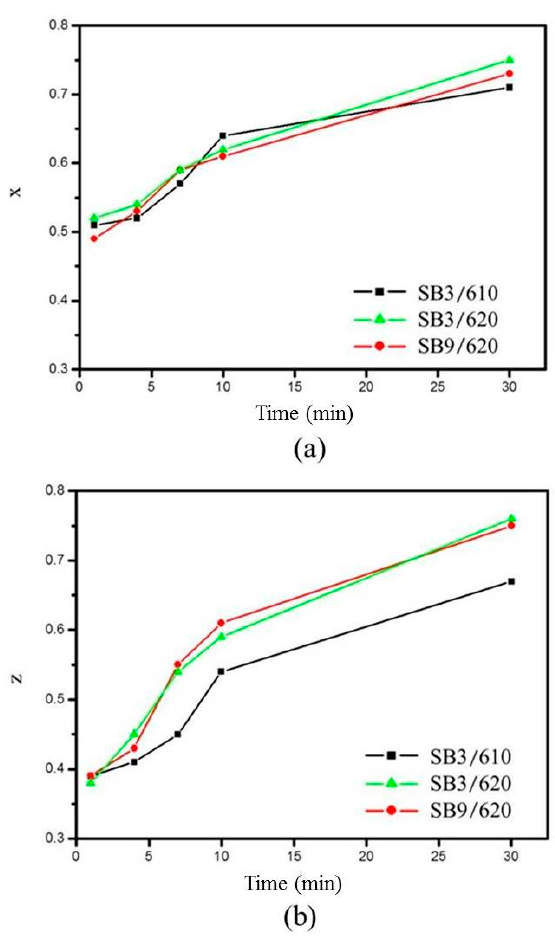
Figure 9. Variation of degree of spheroidization with salt bath conditions: ( a ) x and ( b ) z . The evolution of elemental distribution was analyzed using EPMA. The results are shown in Figure 10. Mg, Si, Cu, and Mn, the four major elements added, were distributed uniformly in the as-extruded alloy. After the salt bath, Mg, Si, and Cu were located at the grain boundaries and formed a network structure, but Mn aggregated as compound particles. This was due to the melting points of Mn-rich phases being higher than 620 ˝ C [19]. Figure 11 shows the phase analysis using the wavelength-dispersive X-ray spectrometer (WDS) of EPMA. The brighter plate-like grain boundary particles, those marked by “d”, are mainly composed of Si and Cu. It is composed of the eutectic phase of Al and Al 2 Cu and the eutectic phase of Al and Si. The darker particles marked by “c” on the grain boundaries and liquid pools are composed of mostly Si and Mg. It is speculated to be the phase aggregation of Al, Mg 2 Si, and excess Si. Moreover, Si, Mn, Cr, and Fe are the major elements of the brighter equiaxed particles on the grain boundaries and in the grain interior (see those marked by “a”). These particles should be the Al 15 (Fe,Mn,Cr) 3 Si 2 phase with a melting temperature close to 660 ˝ C. Its particle size increases with increasing the salt bath duration. The coarsening mechanism of the particles probably follows Ostwald ripening, a Gibbs-Thompson effect to reduce the total surface